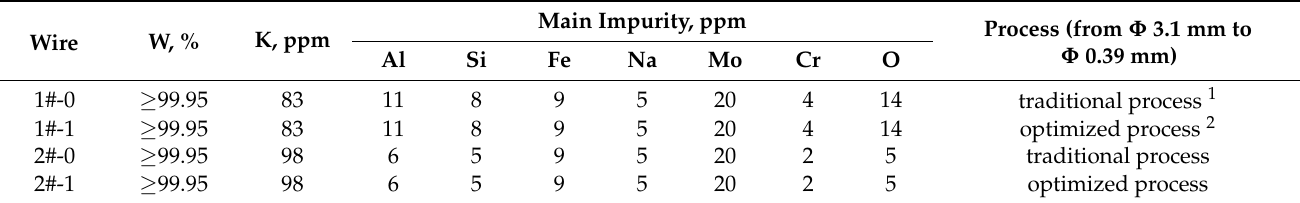
Table 1. Details of the prepared Φ 0.39 mm tungsten wires.